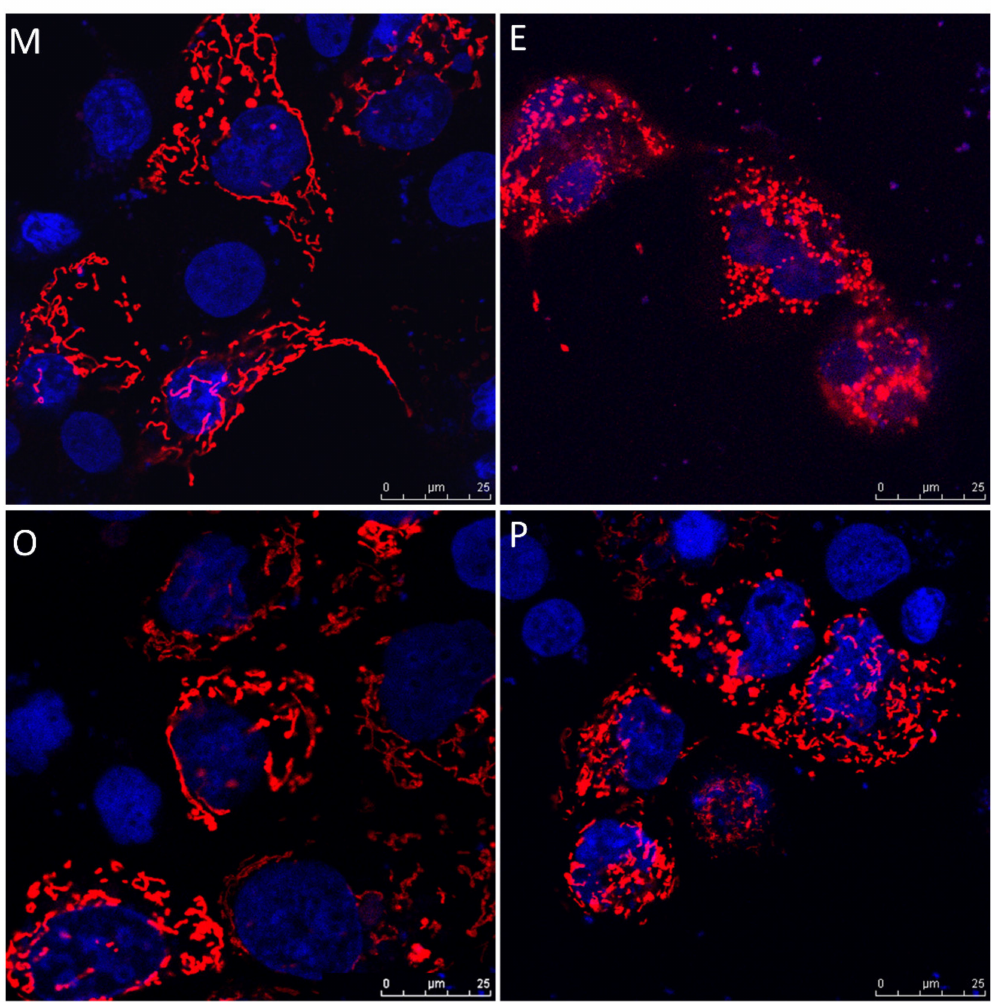
Figure 8. Representative immunofluorescent images for mitochondrial morphology in male factor ( M ), endometriosis ( E ), other female factors ( O ), and polycystic ovary syndrome ( P ). Images of cumulus cells from in vitro fertilization (IVF) patients were analyzed by confocal microscopy to visualize the mitochondrial network and cumulus cell expansion. Representative images show the fragmentation of the mitochondria in the endometriosis group and PCOS group. Scale bar = 25 µ m. 2.9. Lower Levels of Steroidogenic Enzymes were Observed in the Various Infertile Groups Steroidogenic acute regulatory protein (StAR) and 3 beta-hydroxysteroid dehydrogenase (3 β -HSD) are key steroidogenic enzymes. Representative immunoblots of StAR and 3B-HSD from human cumulus cells are shown in Figure 9A. Compared with the male factor group, a significant decrease in StAR (76.8% of male factor) and 3 β -HSD (61.3% of male factor) was found in the patients with ovarian endometrioma. Conversely, increased levels of StAR and 3 β -HSD were detected in the other female factor and PCOS groups (Figure 9B). On the other hand, if the disease group was not di ff erent, the levels of StAR and 3 β -HSD and the patient’s E2 content were statistically analyzed. The results showed that StAR was positively correlated with E2 content (r 2 = 0.1711, p < 0.027), and 3 β -HSD was negatively correlated with E2 content (r 2 = 0.382, p = 0.292) (Figure